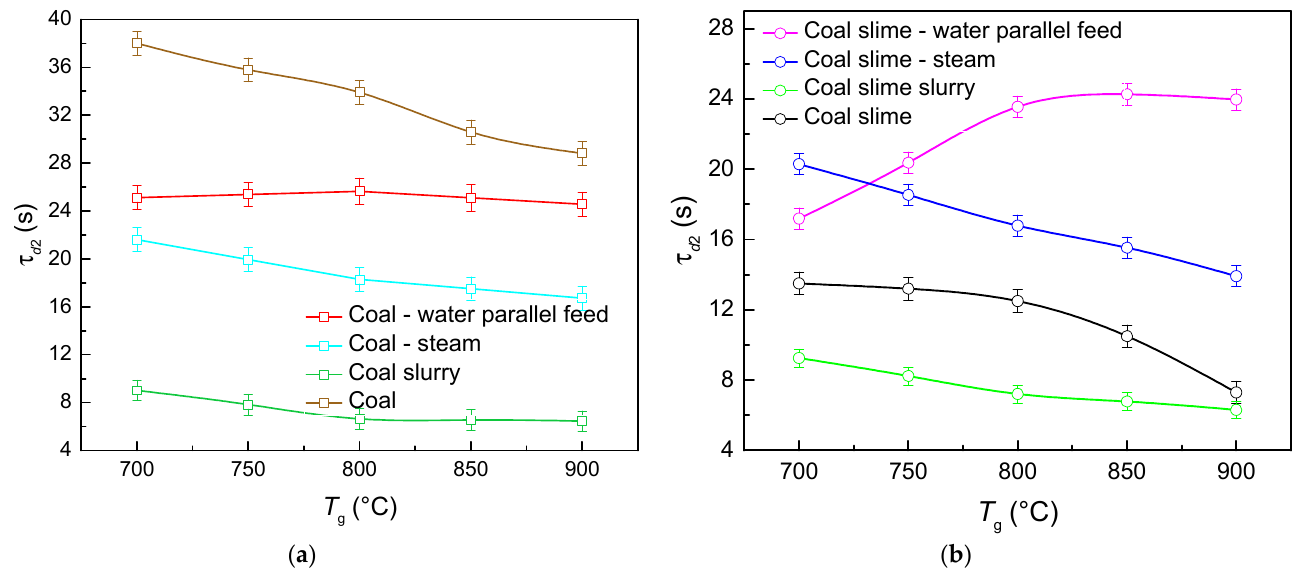
Figure 5. Heterogeneous ignition delay times of fuels based on bituminous coal ( a ) and coal slime ( b ) when varying the method of introducing the components and temperature into the combustion chamber.